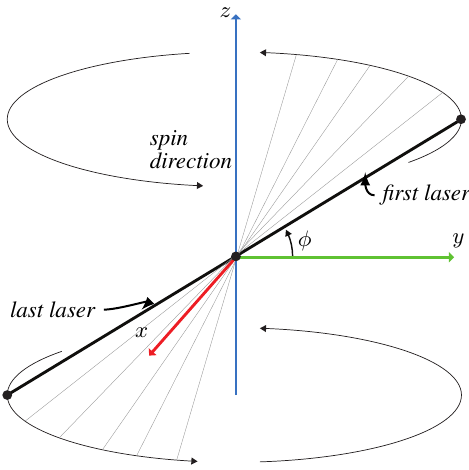
Figure 1. Scan mechanism for a typical spinning multi-beam